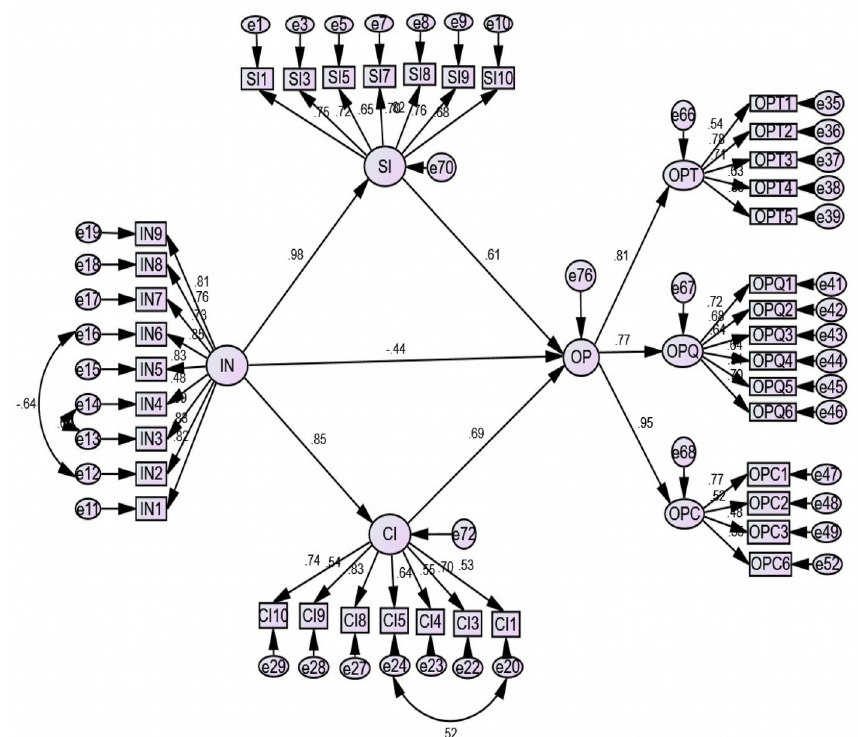
Figure 1. Structural model of the relationship between supply chain integration and operational